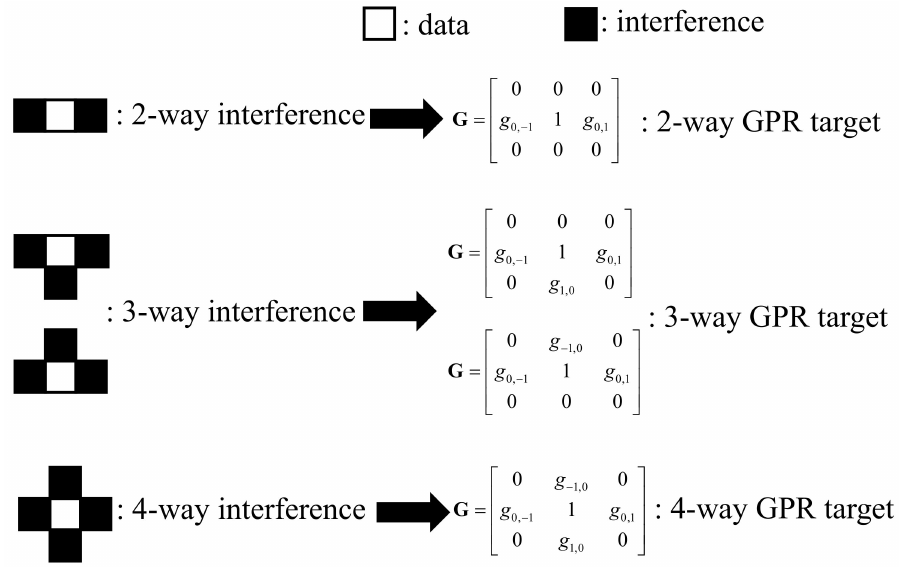
Figure 2. Cases of N-way